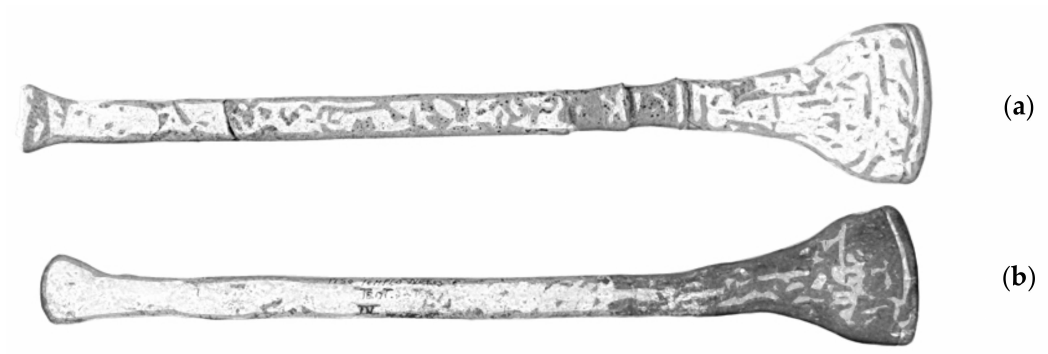
Figure 15. Teotihuacan ceramic trumpets: ( a ) (Met, Inv. 2002.186), length: 29.5 cm; ( b ) (MNA, Inv. 10-222559), length: 28.0 cm.